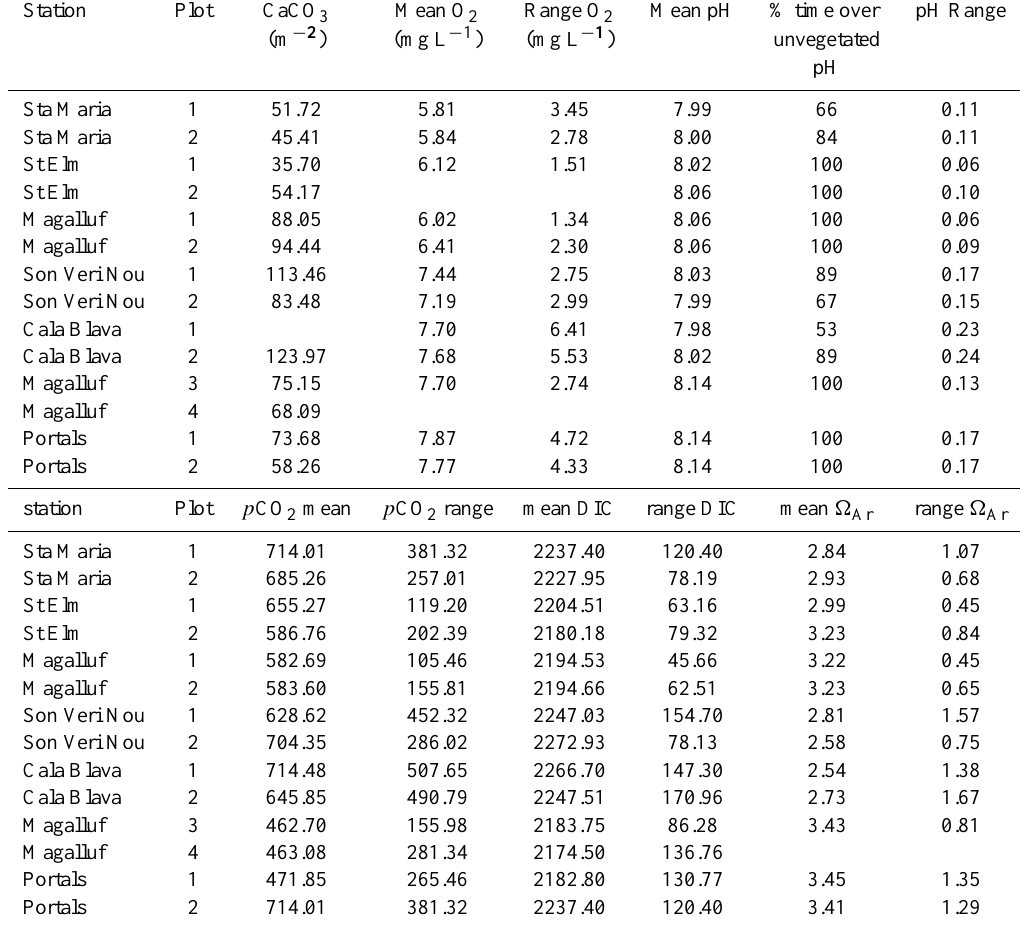
Table 2. Biogeochemical parameters of the carbonate system (mean and range pH NBS measured as well as the estimated % of time the pH was maintained above the hypothetical threshold where no vegetation would be present (LAI = 0); p CO 2 , DIC and (cid:127) Ar calculated with the excel version of CO2SYS), oxygen concentration in the canopy (mgL − 1 ) and CaCO 3 (m − 2 ) content of seagrass leaves in the